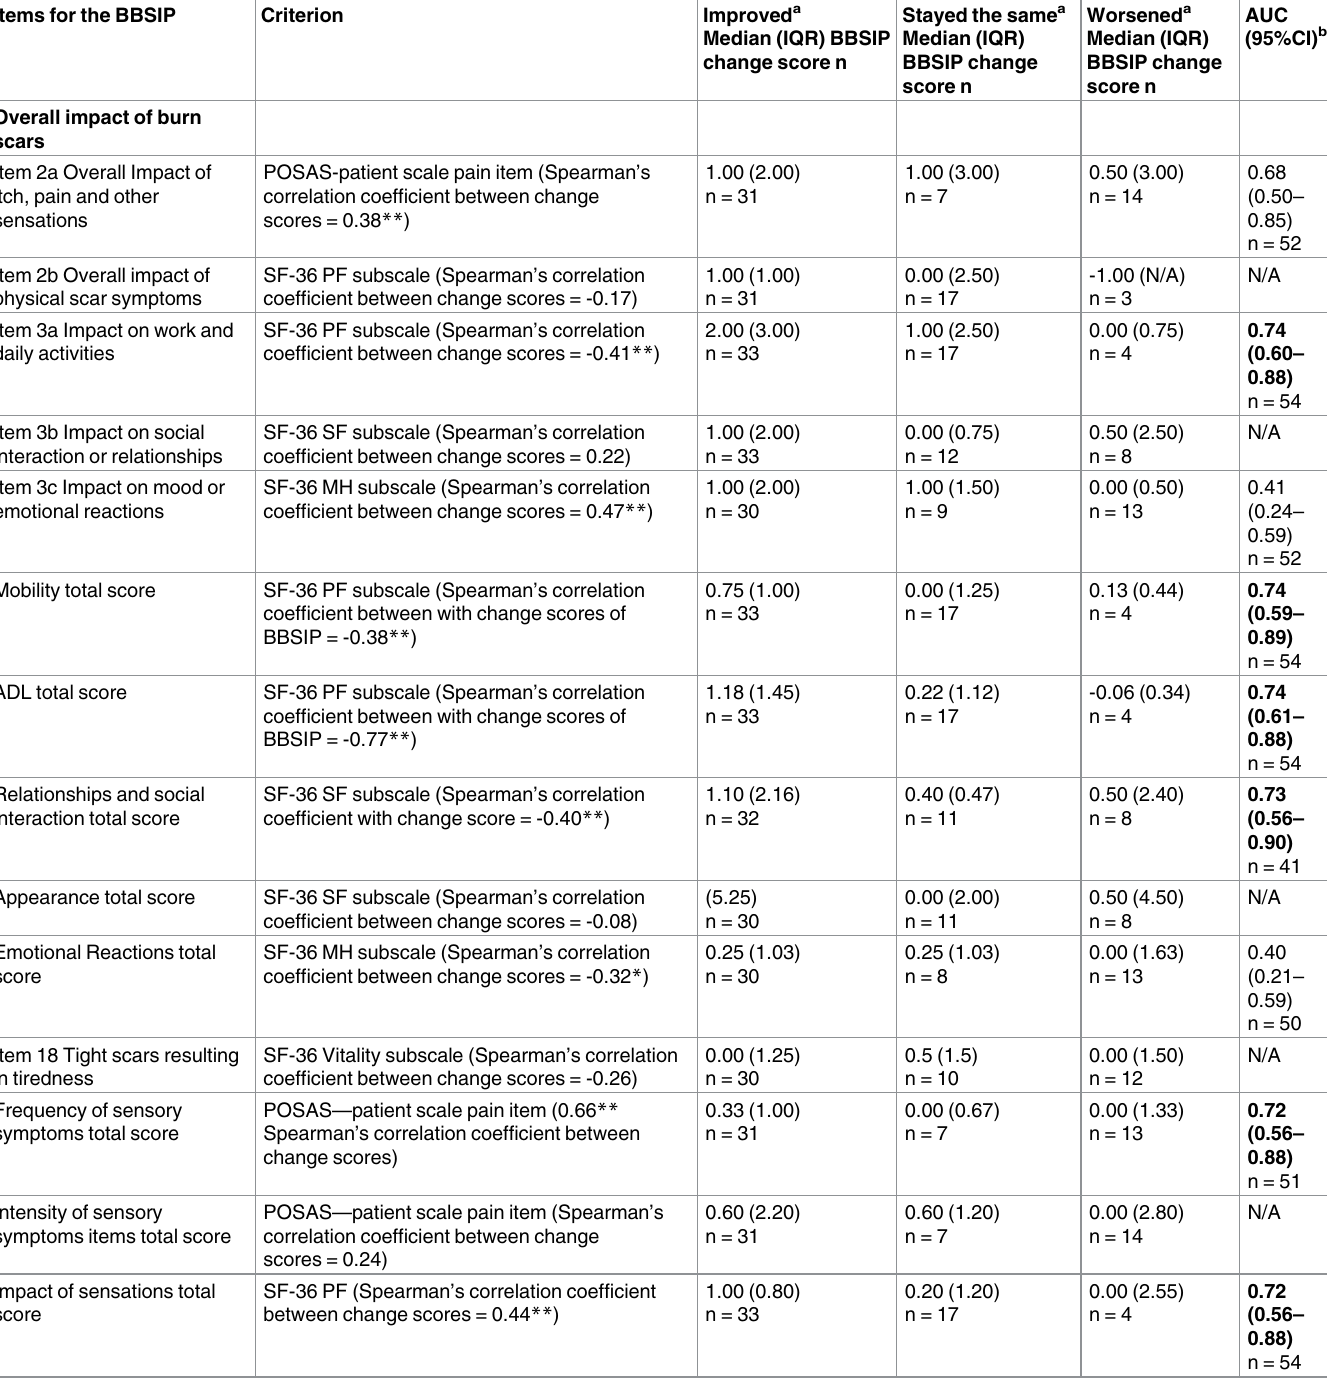
Table 5. Descriptiveand AUC statistics for BBSIP items and subscale scores in people classified as stable, improved or worse on external crite- rion at 1-month follow-up. Items for the